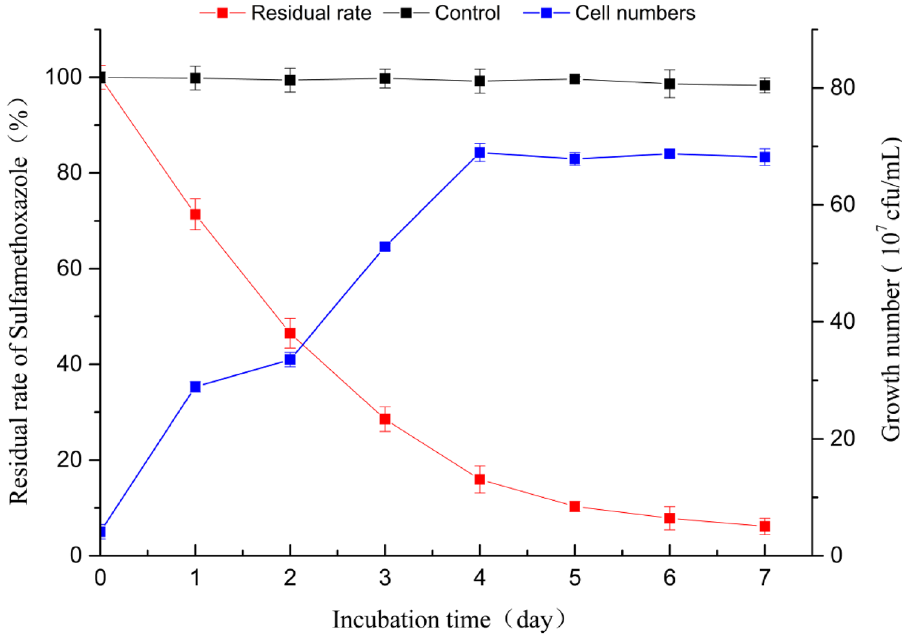
Figure 6. Growth of S. mizutaii LLE5 along time and degradation efficiency of SMX. The symbols represent averages of triplicate experiments and the error bars indicate their corresponding standard deviations.